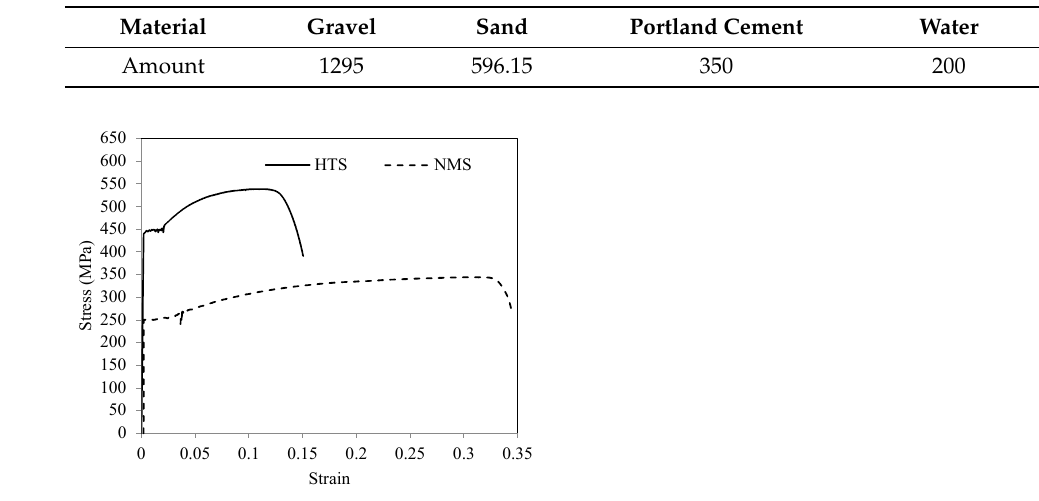
Figure 5. The stress–strain curves of the reinforcing bars.